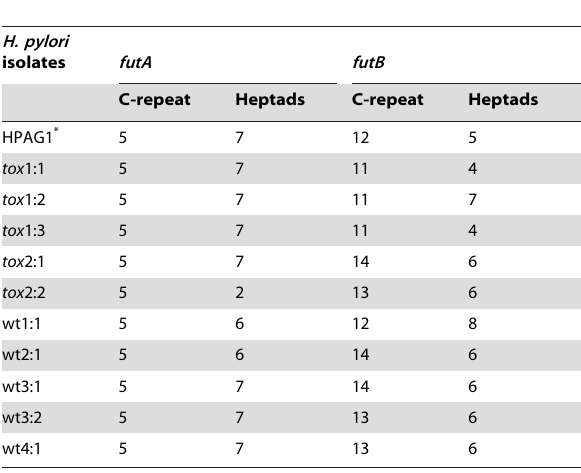
Table 1. Sequencing results of futA and futB of HPAG1 isolates after a one-year colonization of germ-free tox 176 and wildtype (wt) mice.